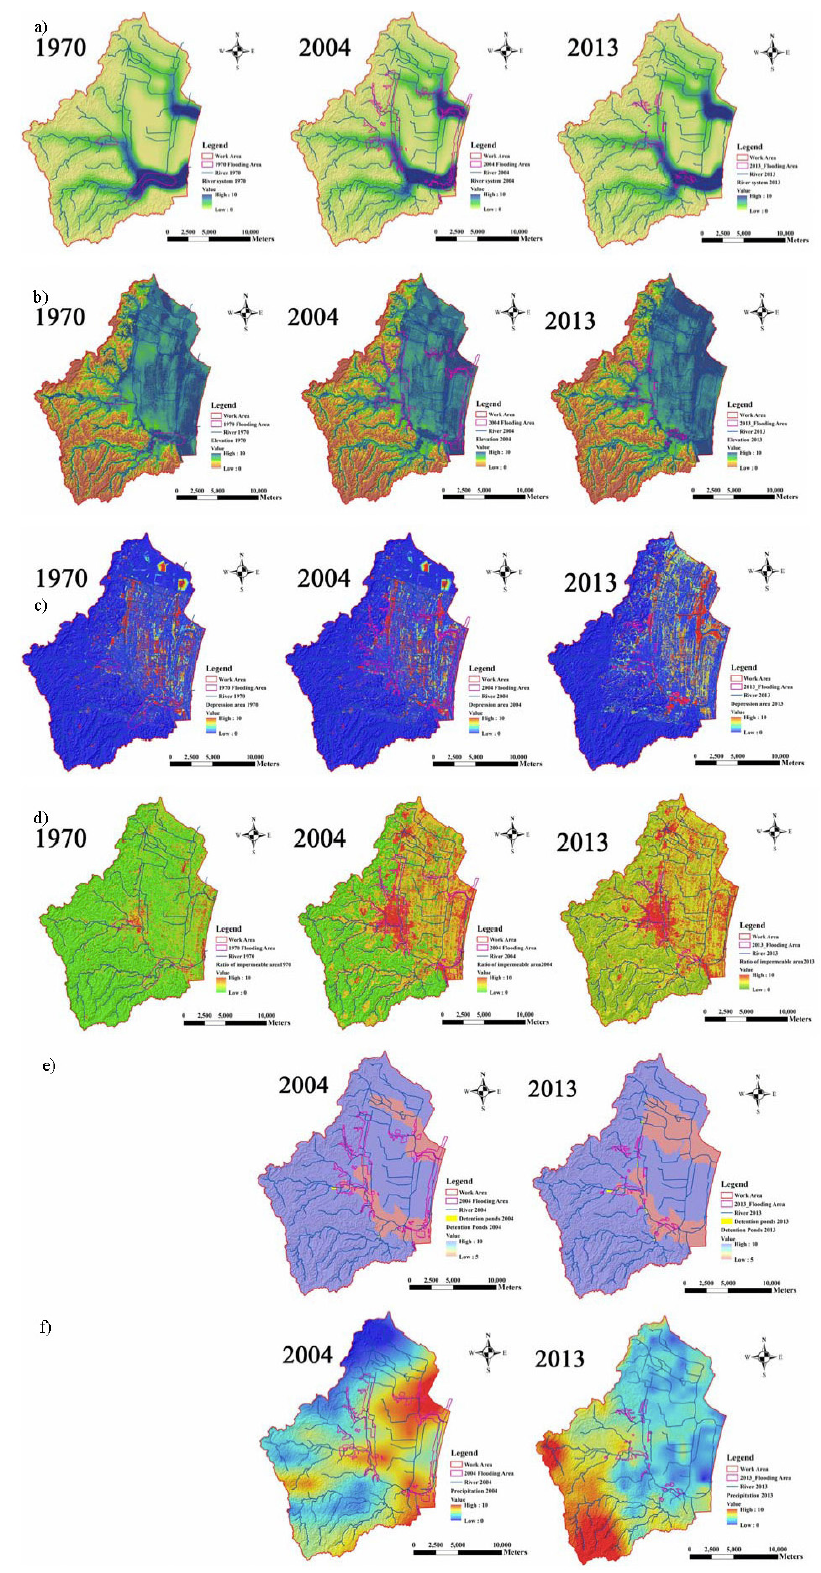
Figure 3. The images of each layer for the flood hazard assessment. The areas surrounded by pink line show the ones actually flooded. Figures in the left column are those for year 1970, the center for year 2004, and the right for year 2013. (a) River system layer, (b) elevation layer, (c) depression area layer, (d) ratio of impermeable area (Ratio of IA) layer, (e) detention ponds layer, and (f) precipitation